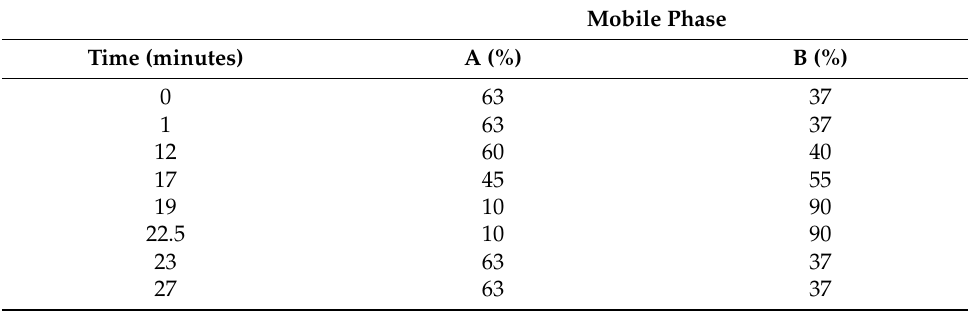
Table 3. Gradient used for the liquid chromatography mobile